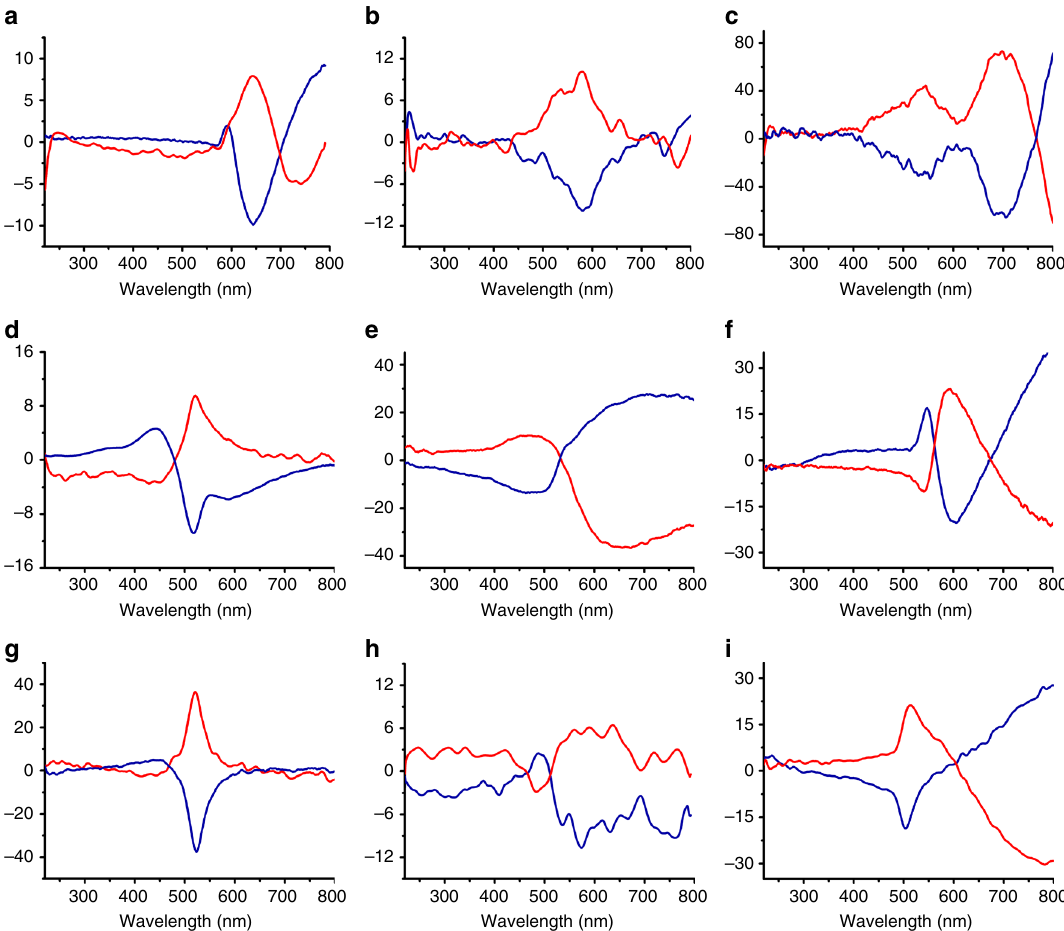
Fig. 3 The solid-state CD spectra of CCOFs. a TpPa-1, b TpPa-2, c TpPa-Py, d TpBD, e TpBD-Me 2 , f TpBD-(OMe) 2 , g TpBpy, h TpTd, and i TpTab, respectively. CCOFs induced by ( R )-1-PEA (red line) and by ( S )-1-PEA (blue